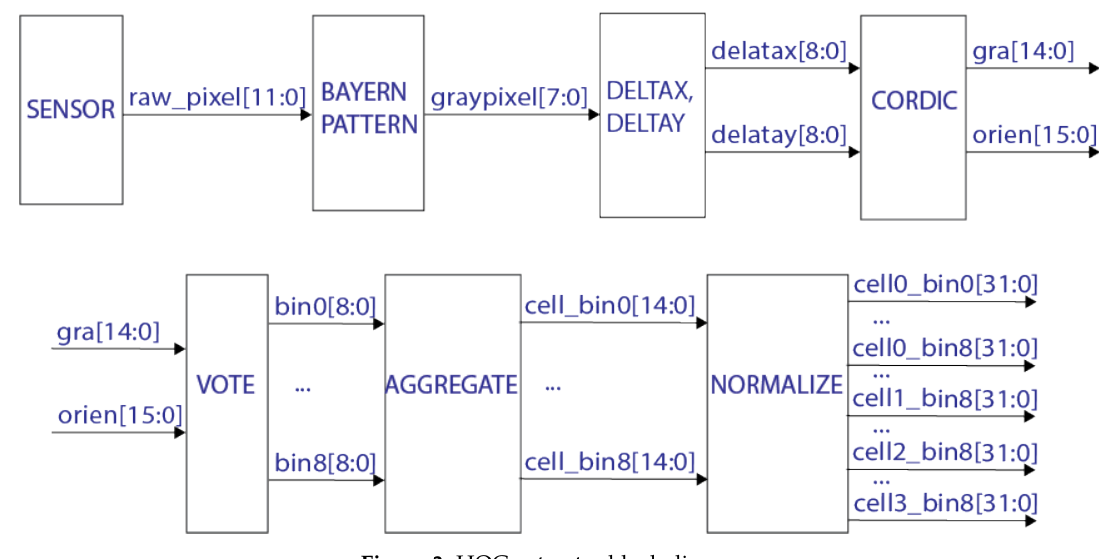
Figure 3. HOG extractor block